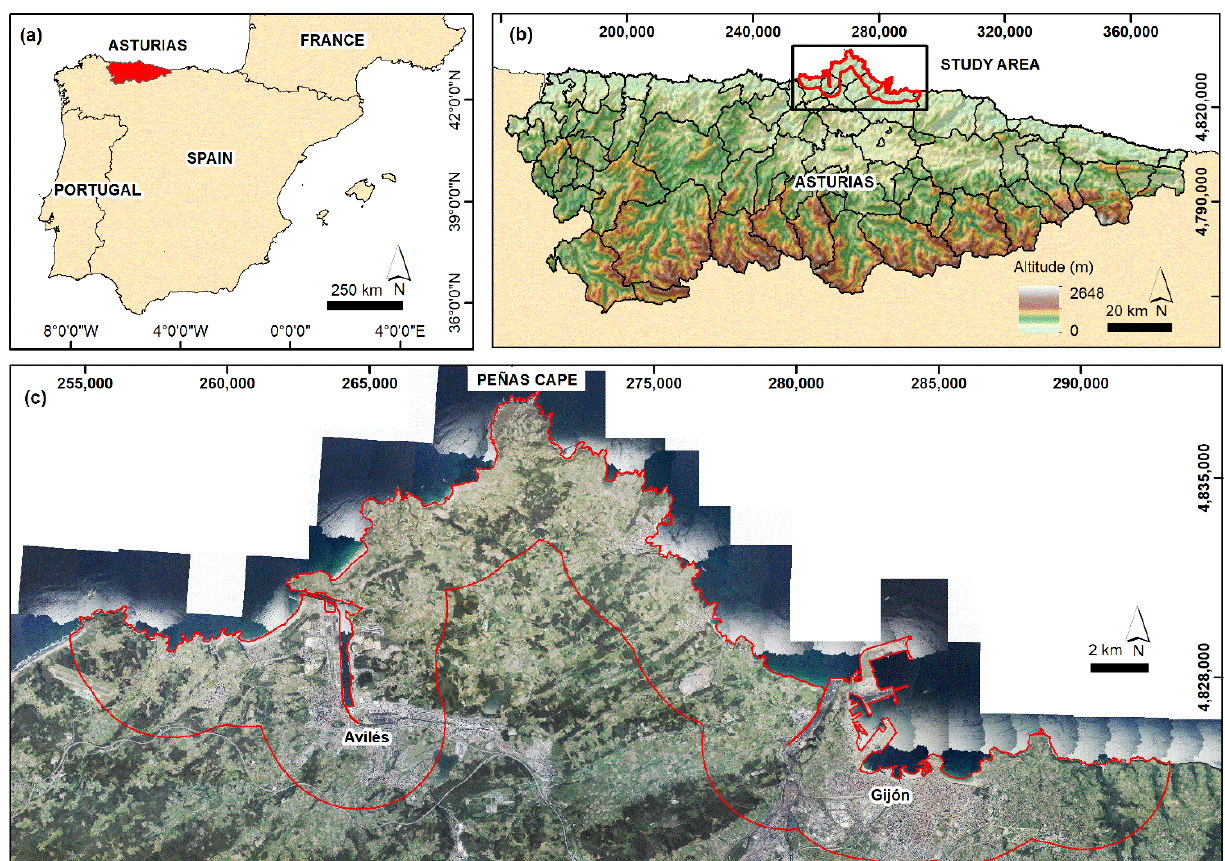
Figure 1. ( a ) Location of Asturias in the N of Spain; ( b ) central coast of Asturias study area; ( c ) study area, with principal cities of Avilés and Gijón and the Peñas Cape location; OrtoPNOA 2017 CC-BY 4.0 scne.es.